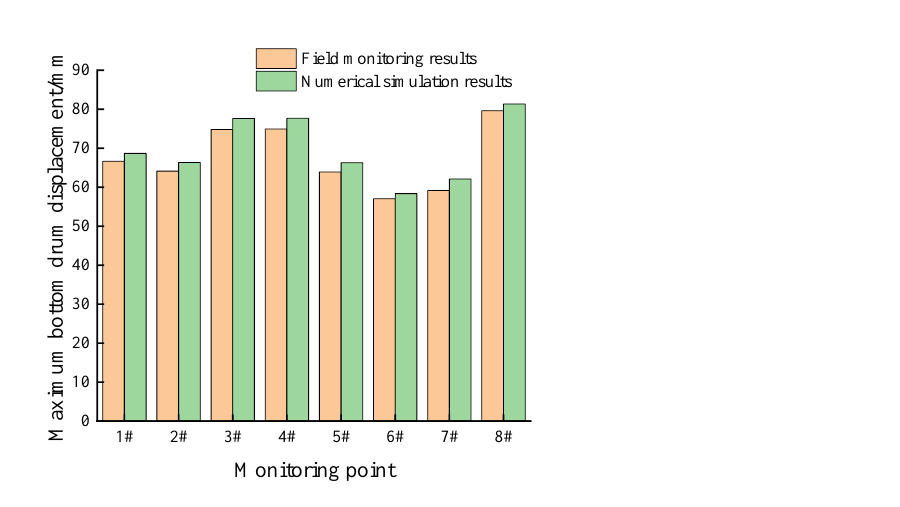
Figure 20. Numerical simulation results versus the field monitoring results of the maximum bottom drum displacement.